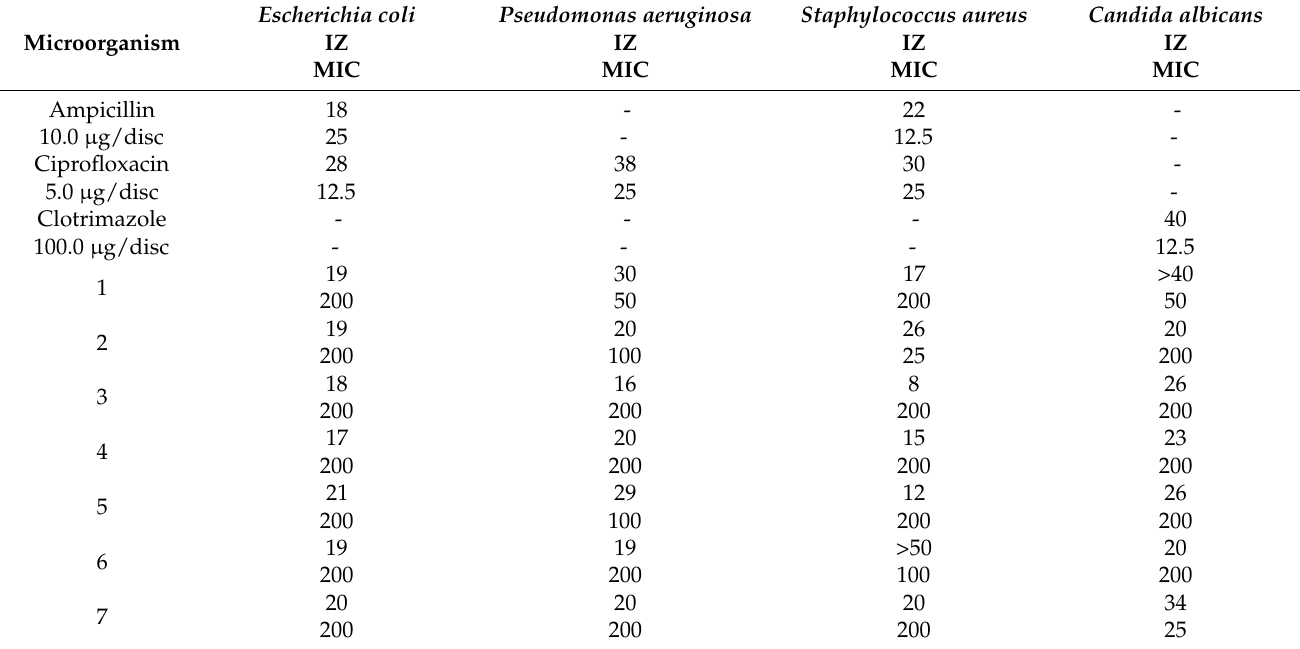
Table 2. Inhibition zones and MICs of compounds 1 – 7 , ampicillin, ciprofloxacin and